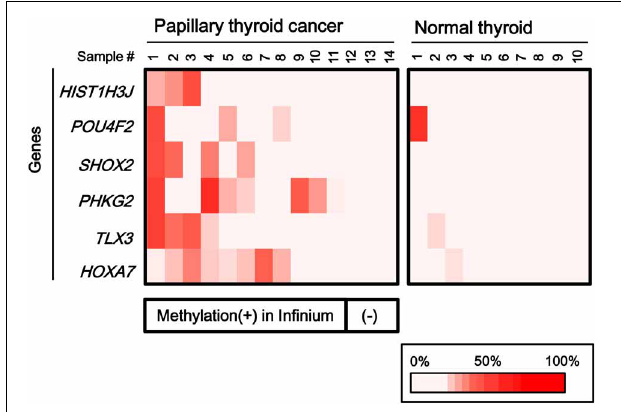
FIGURE 4 | Confirmation of aberrant methylation by pyrosequencing. Six genes were randomly chosen among the 25 frequently methylated genes, and their methylation status was quantitatively validated by pyrosequencing, using the 14 papillary thyroid cancer samples and 10 normal thyroid samples that were analyzed by Infinium. Although one normal sample showed high methylation in POU4F2 , aberrant methylation of the six genes in the papillary cancer samples was confirmed. Bottom , the corresponding data for aberrant methylation obtained by Infinium analysis ( Figure 3 ).